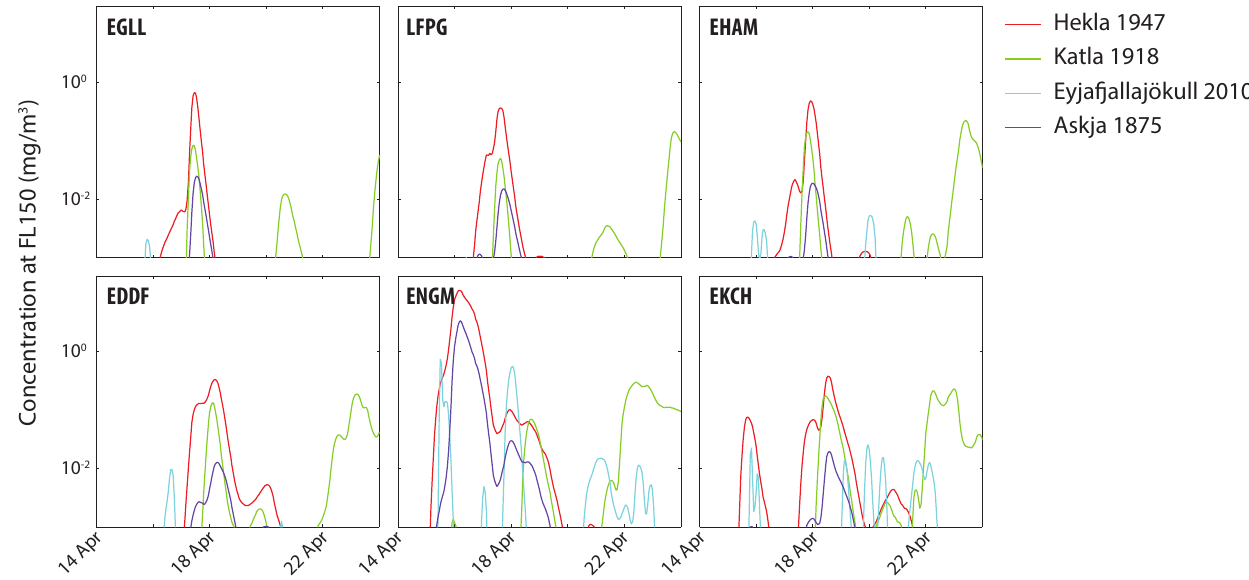
Figure 14. Airborne concentration of ash at FL150 above the airports of London Heathrow (EGLL), Paris Charles de Gaulle (LFPG), Ams- terdam Schiphol (EHAM), Frankfurt (EDDF), Oslo Gardermoen (ENGM) and Copenhagen Kastrup (EKCH) resulting from the eruptions of Hekla 1947, Katla 1918, Eyjafjallajökull 2010 and Askja 1875. Each eruption was run for 10 days starting from 14 April 2010 using similar wind conditions that occurred during the Eyjafjallajökull 2010 eruption. Concentrations for other FL can be found in the Supplement.